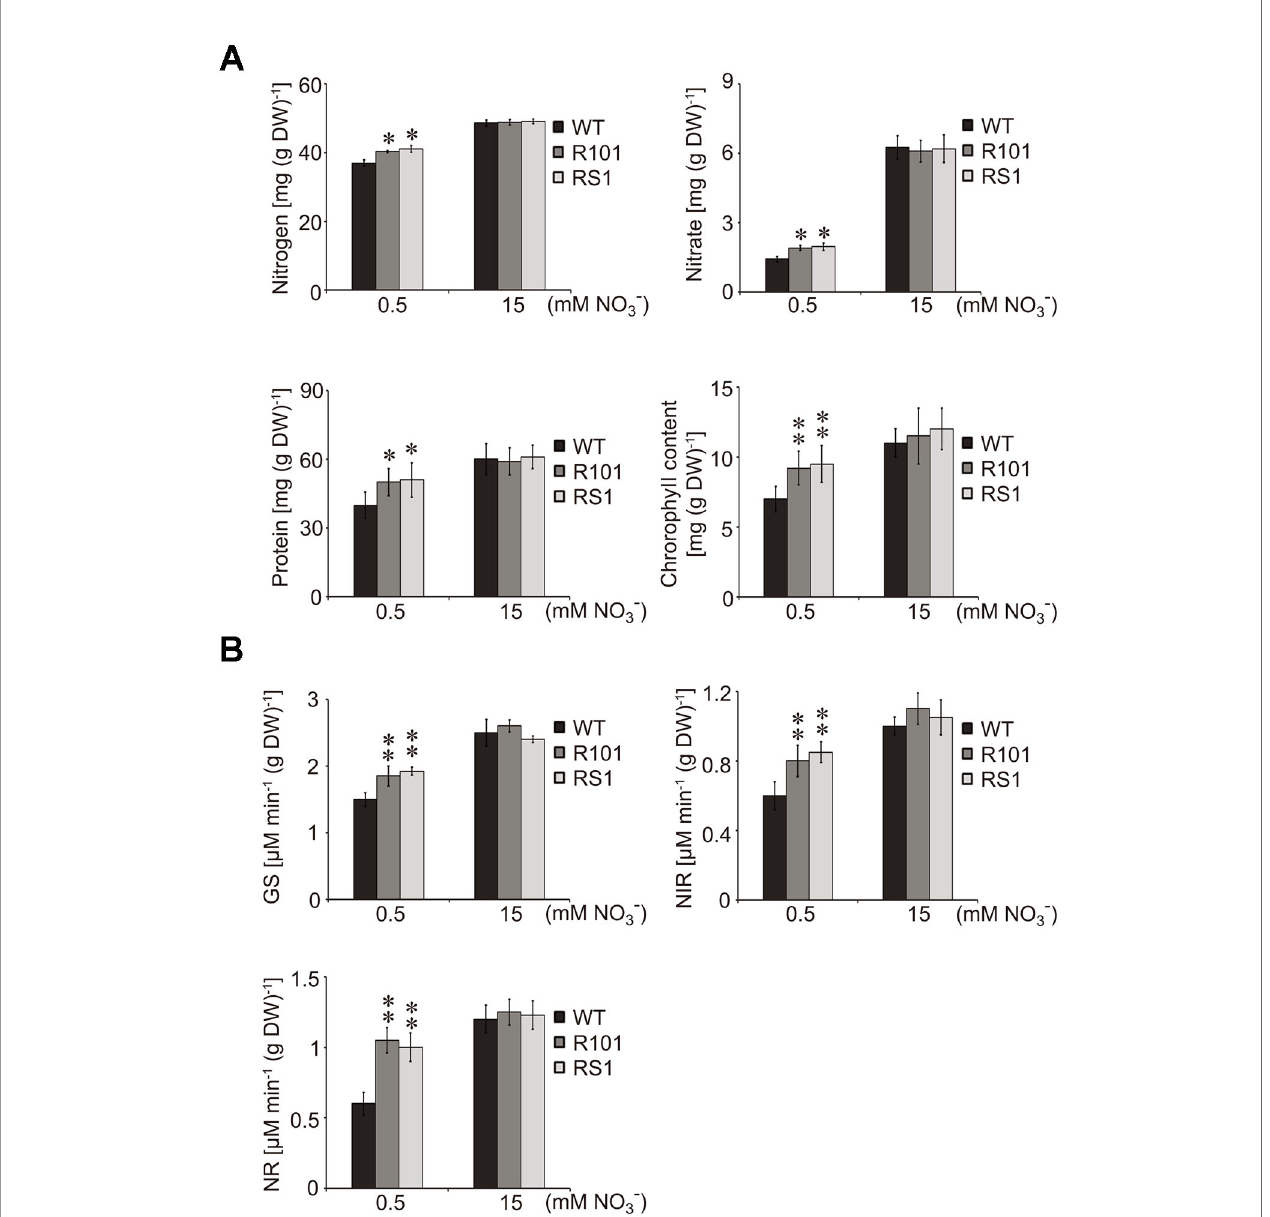
FIGURE 2 | Effects of different concentrations of nitrate on the physiology of maize plants. (A , B) Analysis of the physiological markers of N status in maize including the contents of N, nitrate, soluble protein, and chlorophyll (A) as well as the activities of glutamine synthetase (GS), nitrate reductase (NR), and nitrite reductase (NIR) (B) . The WT and ZmCHB101-RNAi seedlings were grown in Hoagland's nutrient solution containing 0.5 or 15 mM nitrate for 5 days and used for physiological analysis. Data represent mean ± SD of biological replicates ( n = 3). Asterisks indicate signi fi cant differences (*, p < 0.05; **, p < 0.01; Student's t